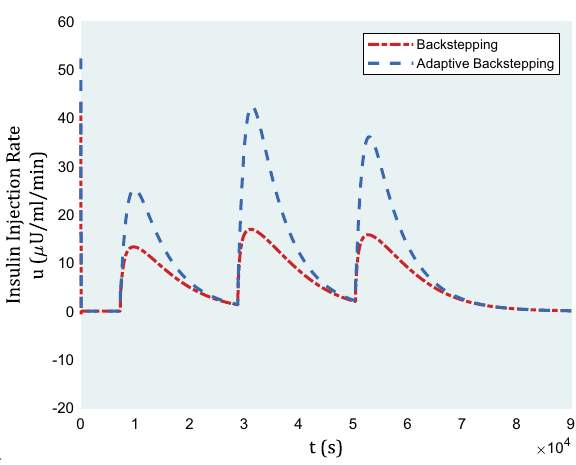
Figure 8. Insulin injection in the presence of actuator faults under the control